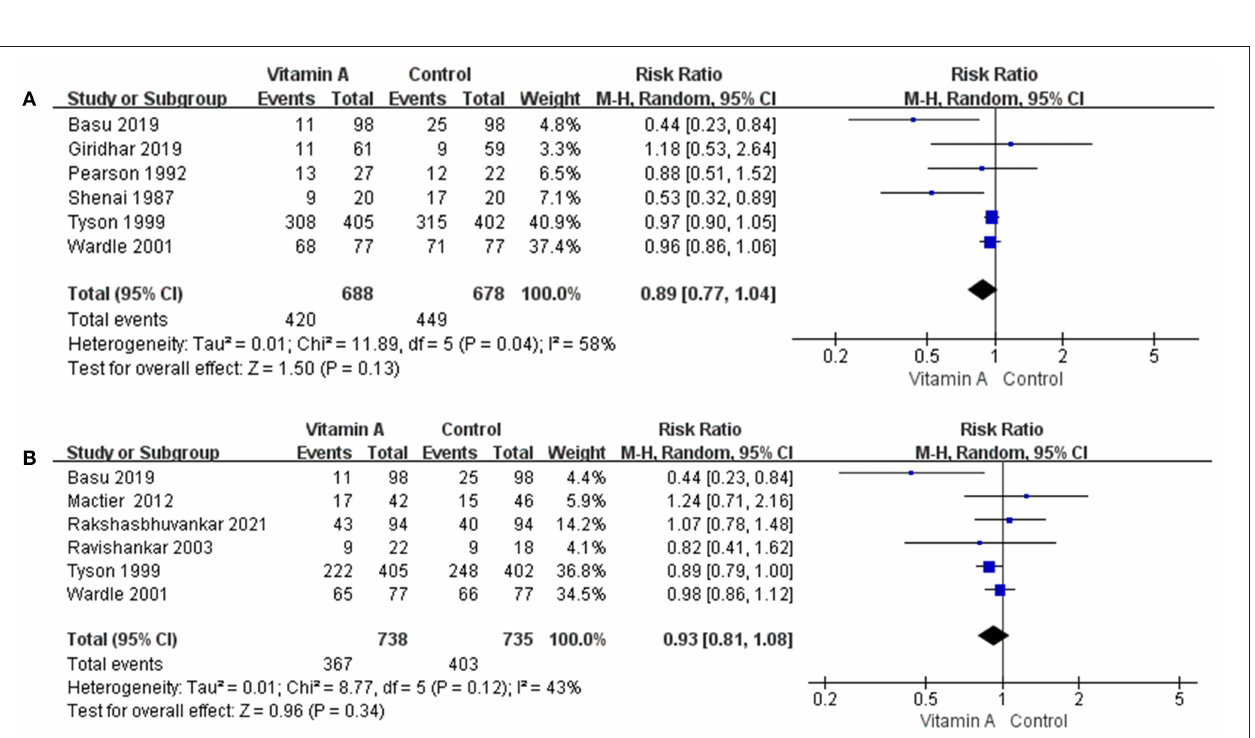
Frontiers in Pediatrics |